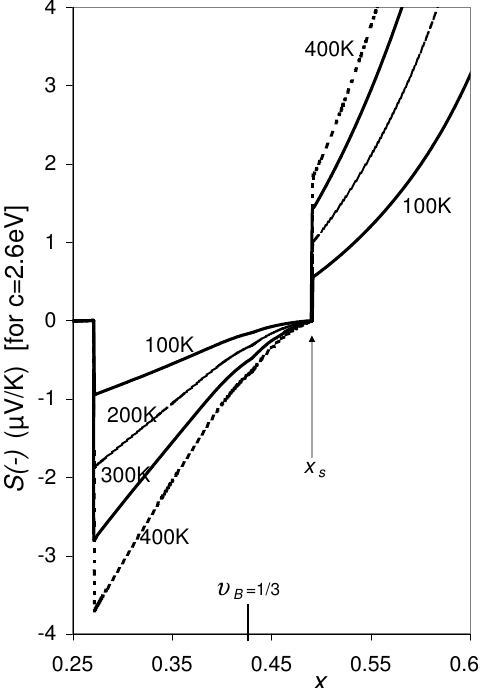
Figure 6. Same as Figure 1, however S ( − ) vs. x calculated for different temperatures: T = 100, 200, 300, and 400 K. The discontinuity at x = 0.27 disappears if S 0 which is a better approximation than given by Equation (3) and Equation (4), because the phase B does no longer form a macroscopic cluster through the alloy; at υ B = 1/3 the energy spectrum changes from a quasi-continuous spectrum ( υ B > 1/3) to a discrete energy spectrum ( υ B < 1/3) typical for separate phase grains